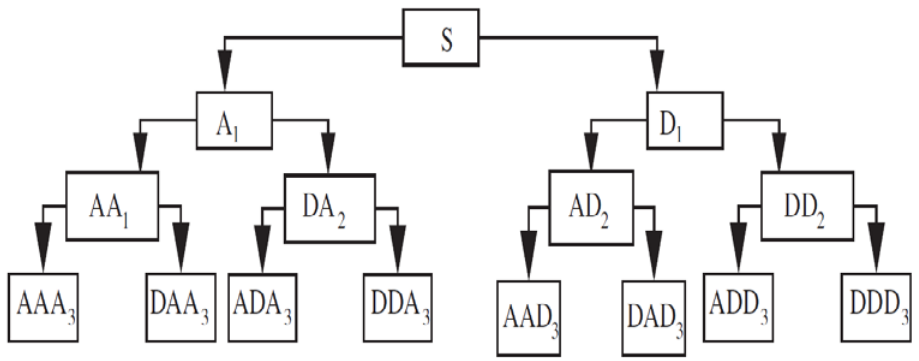
Figure 2. Wavelet Packet decomposition tree.